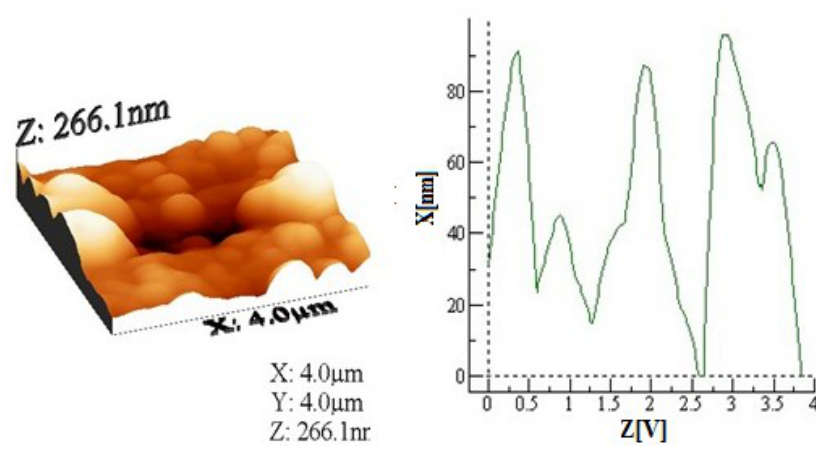
Figure 4. AFM and its line profile image of polyreactive blue MXR dye is in 3D